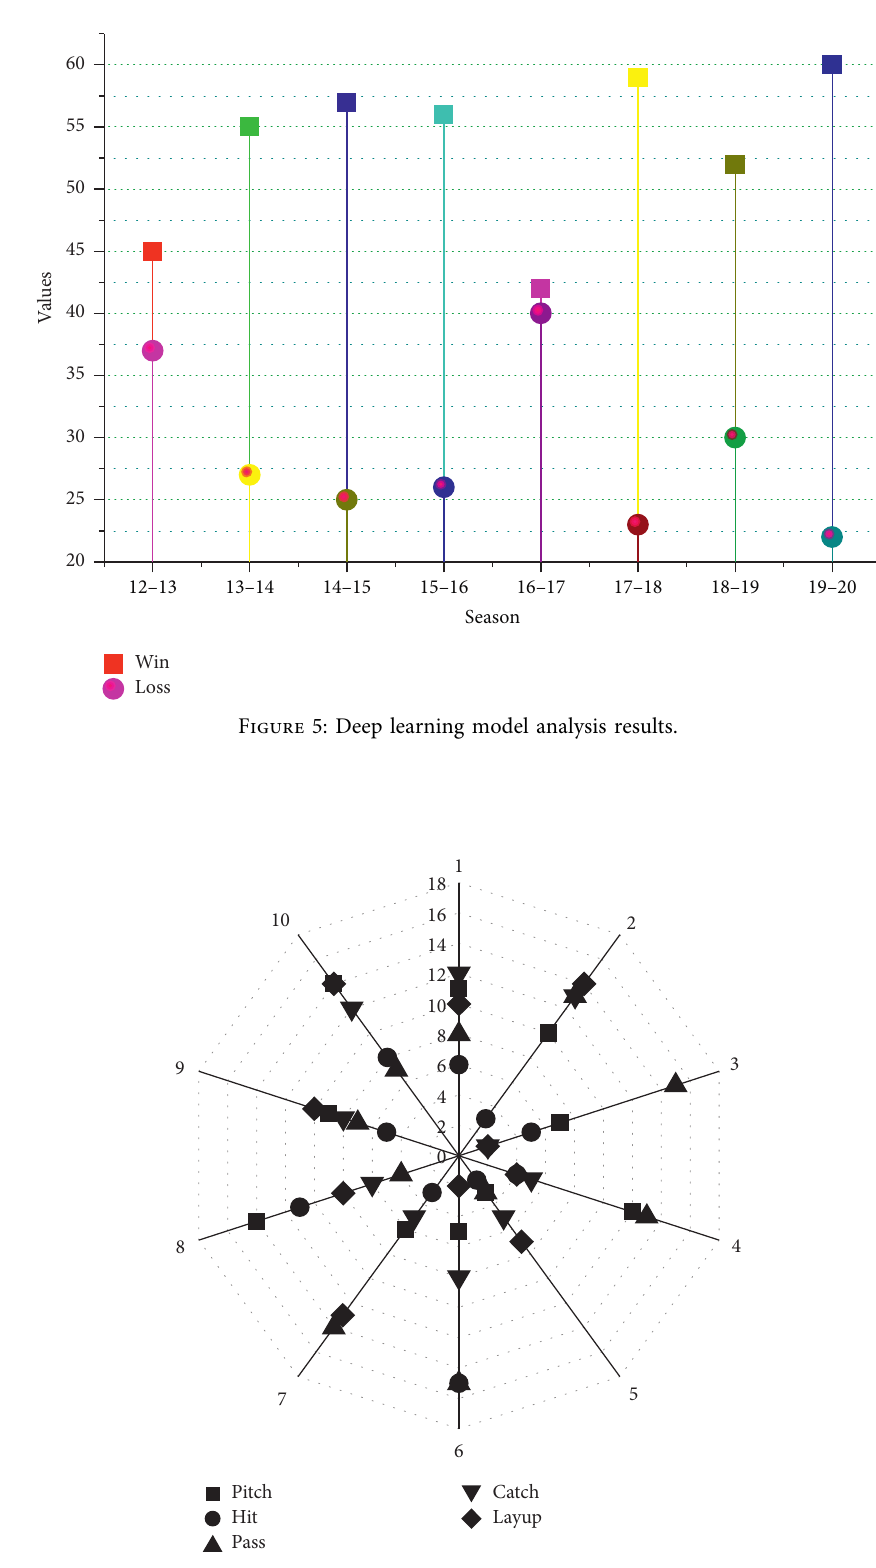
Figure 6: System statistics and manual statistics